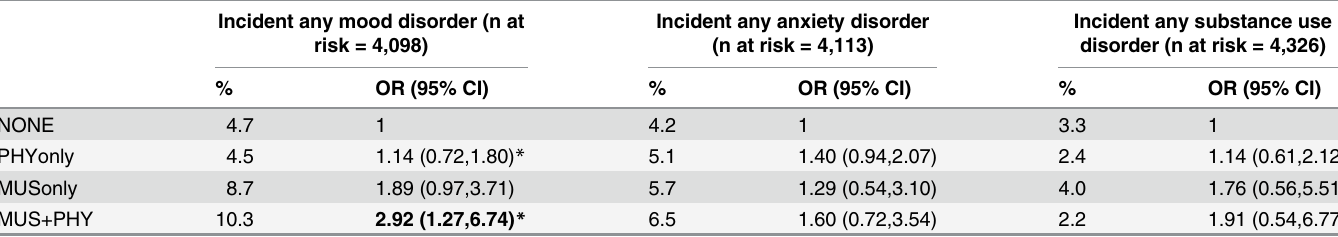
Other analyses: When PHYonly, MUSonly and MUS+PHY were respectively used as the reference group, the only significant difference was that MUS+PHY showed a higher OR for substance use dis- order when compared to PHYonly. However, this does not change the general direction of our results. Incidence rates. The 3-year incidence rates and ORs of mood disorder, anxiety and sub- stance use disorder are reported in Table 4. Because first-incidence rates were calculated, the Table 4. 3-year incidence of (comorbid) common mental disorders. Incident any mood disorder (n at risk =